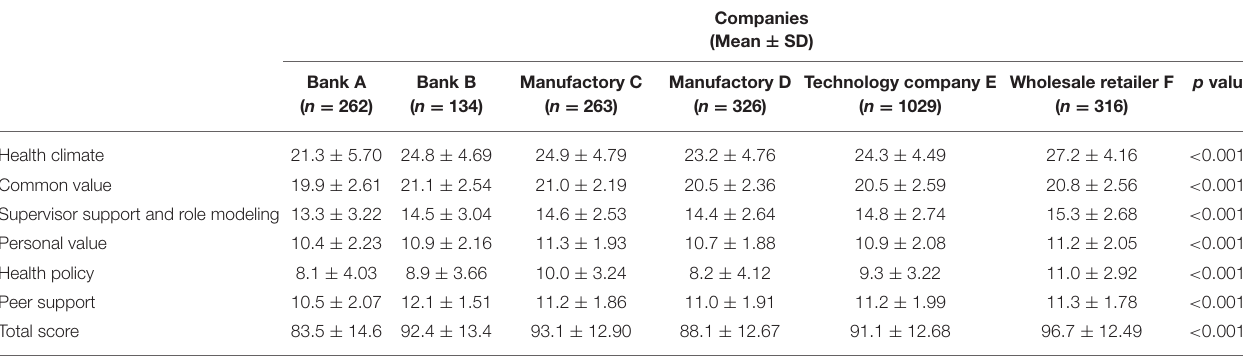
TABLE 5 | The result of discriminant validity